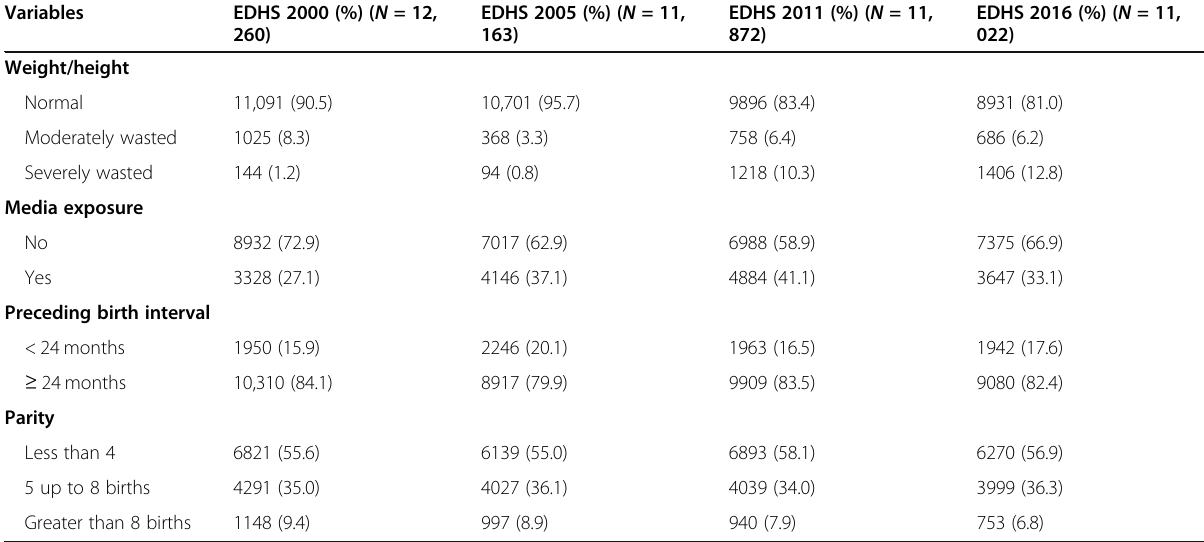
Table 1 Percentage distribution of characteristics of respondents in 2000, 2005, 2011, and 2016 Ethiopian Demographic and Health Surveys